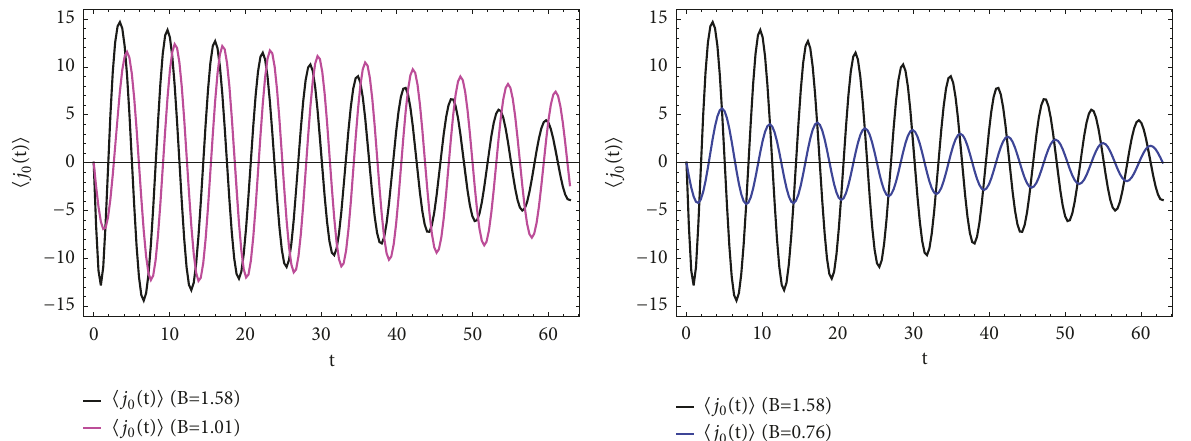
, 𝜔 ) = (3,100,10 −3 ,0.35) for all the lines. In 3, 0 0